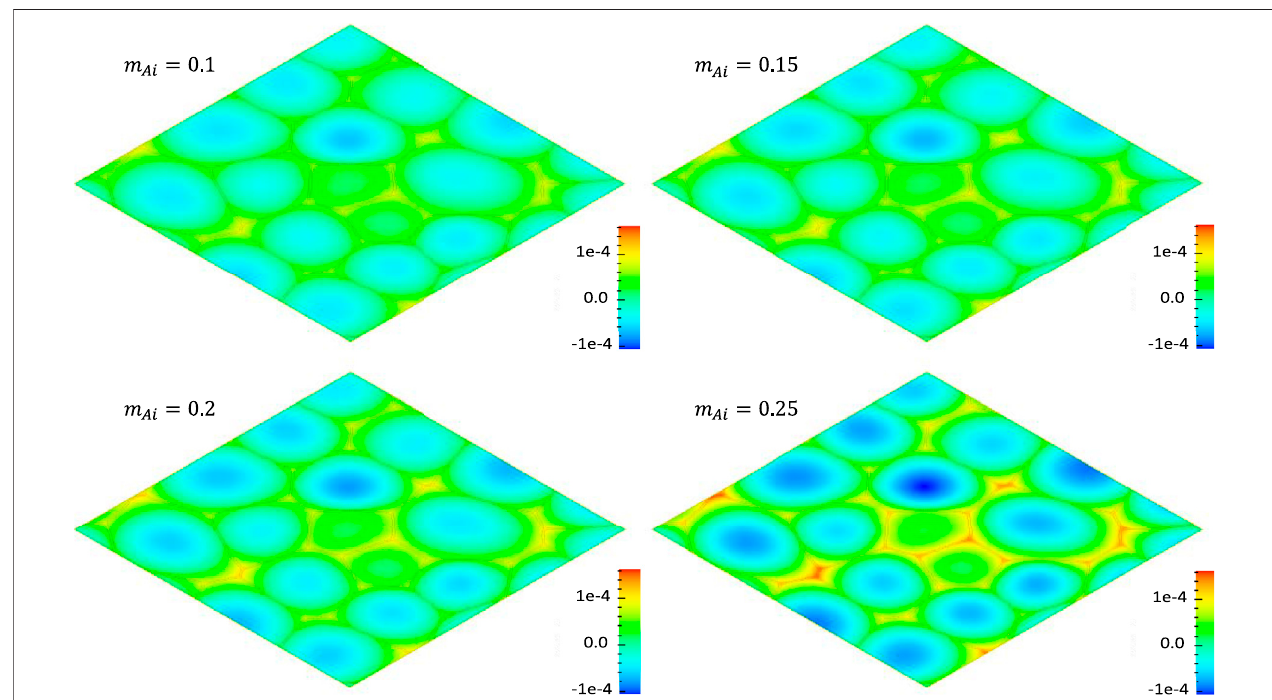
FIGURE 7 | Effect of solute interstitial production ef fi ciency m Ai on the distribution of solute concentration changes Δ c A at time t (cid:2) 8 . 17s.